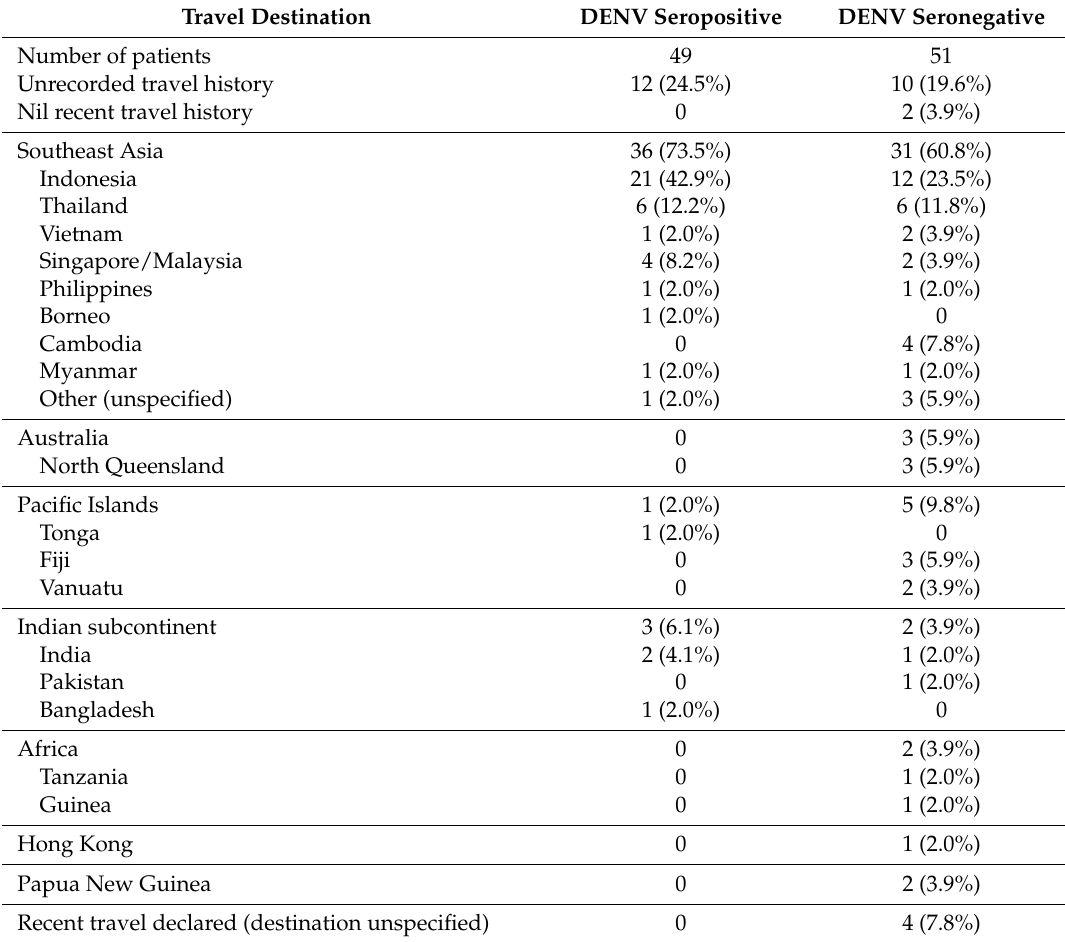
Table 4. Travel histories for DENV-seropositive ( n = 49) and DENV-seronegative patients ( n =